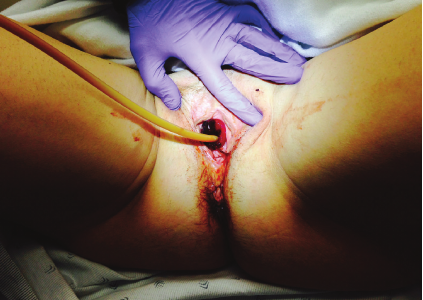
Figure 1: Appearance of strangulated urethral prolapse on physical exam.